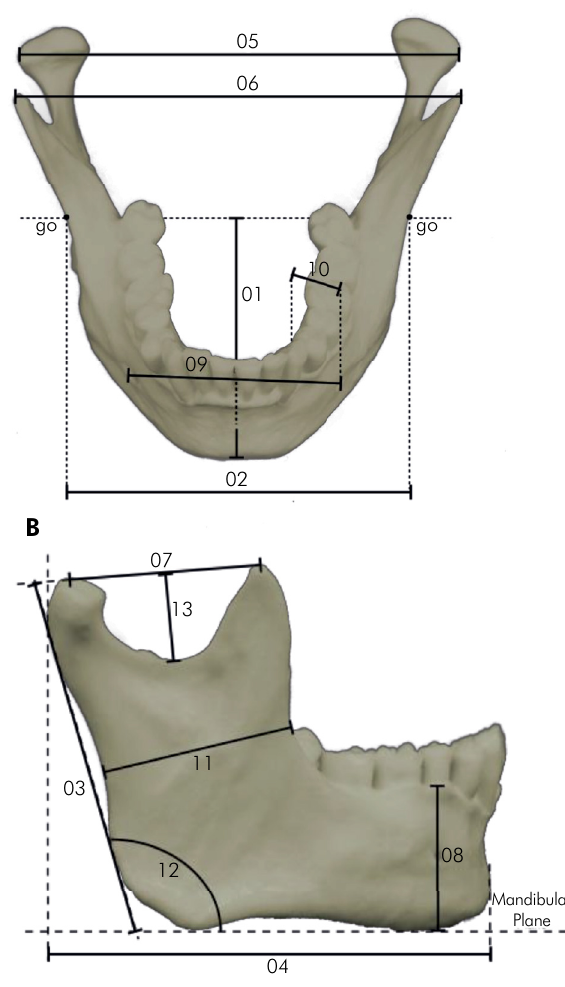
Figure 3. Mandible measurements. 1. maximum mandibular length; 2. bigonial width; 3. maximum ramus height, right and left; 4. mandibular length (projection); 5. bicondylar breadth; 6. bicoronoid breadth; 7. mandibular notch breadth, right and left; 8. height of the mandibular body at the mental foramen, right and left; 9. bimental breadth; 10. breadth of the mandibular body, right and left; 11. minimum ramus breadth; 12. mandibular angle, right and left; 13. mandibular notch depth, right and left.